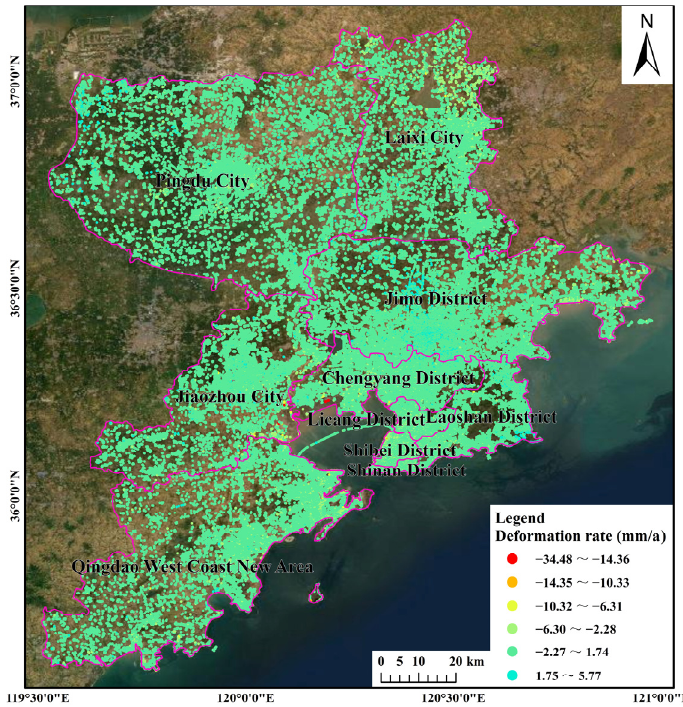
Figure 3. Land subsidence rate in Qingdao from 2017 to 2020.